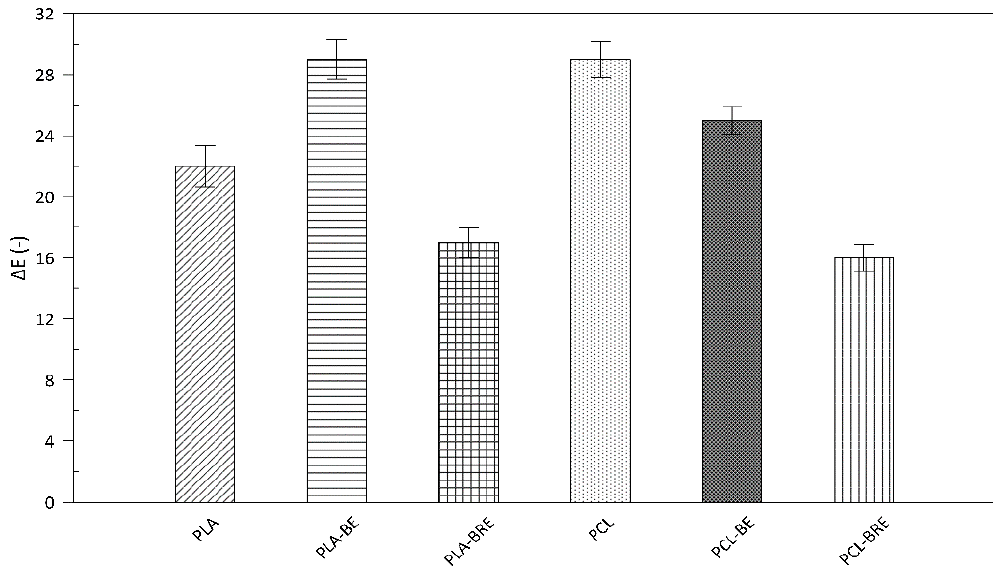
Figure 9. Color change ( ∆ E) in the PLA and PCL composites with bentonite and natural AOs, compared with the reference of pure PLA and PCL; calculations were performed according to Equation (2).